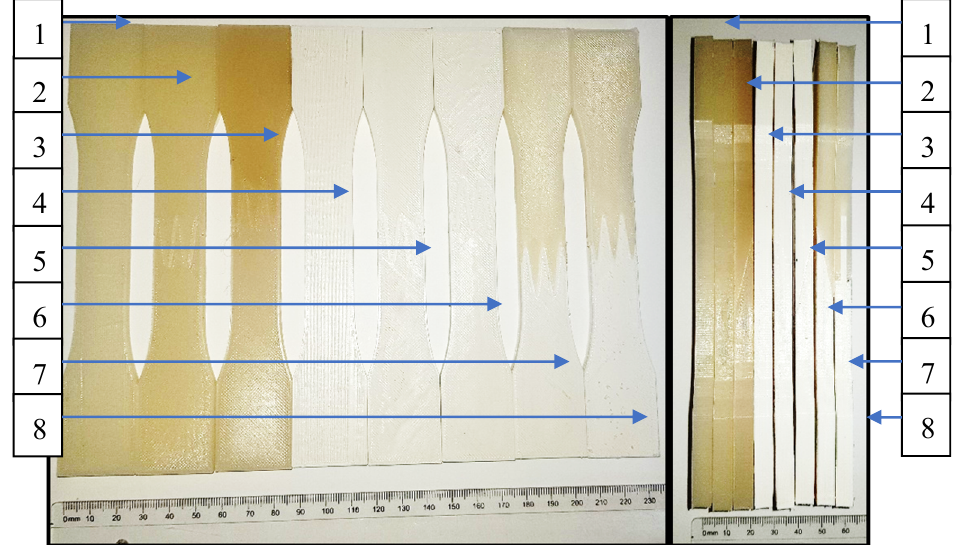
Figure 5. Additively manufactured samples: 1—Monolithic, PLA (PT); 2—Pleated connection, PLA (PTZ); 3—Overlap connection, PLA (PTN); 4—Monolithic, ABS (ABS); 5—Pleated connection, ABS (ABSZ); 6—Overlap connection, ABS (ABSN), 7—Overlap connection, PLA/ABS(PTABSZ); 8—Pleated connection, PLA/ABS (PTABSN).